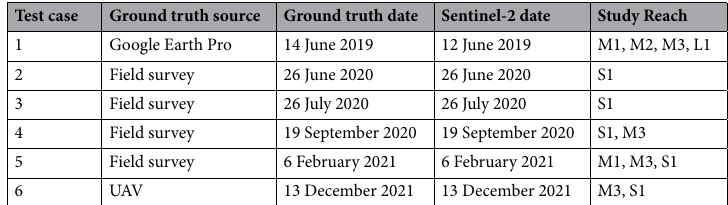
Table 3. Pairs of Sentinel-2 and ground truth images.